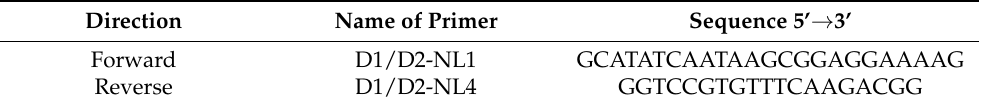
Table 2. Primers used in this work